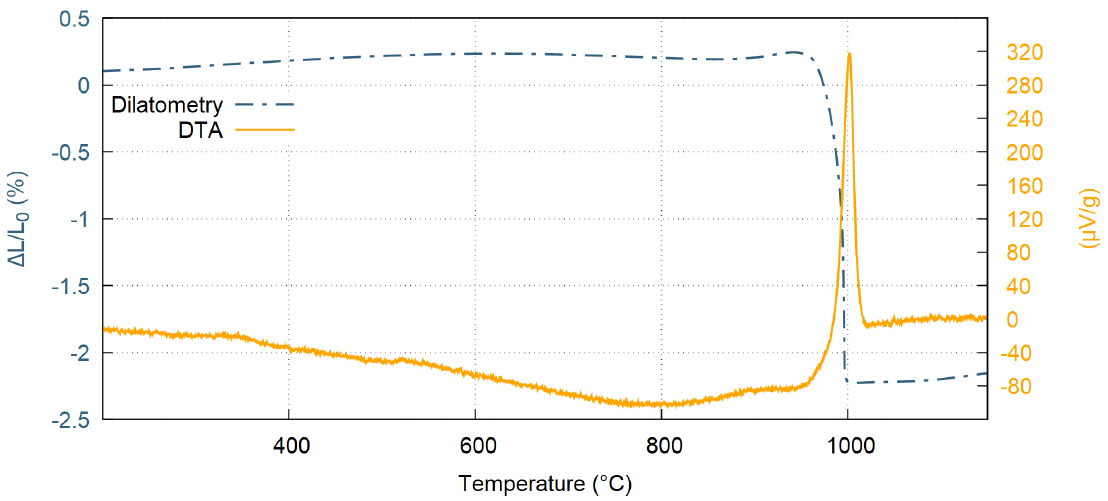
Figure 4. Measurement of differential thermal analysis (DTA) and thermal dilatometry of free standing Al 2 O 3 –ZrO 2 –SiO 2 coatings. Table 1. Used parameters of heat treatment and corresponding microhardness and wear resistance esults. Dwell Time (min) Temperature ( ◦ C) HV0.3 Cracks 1 K (mm 3 / N · m) AS – 639 ± 37 0 1.3 e-2 AS Surface